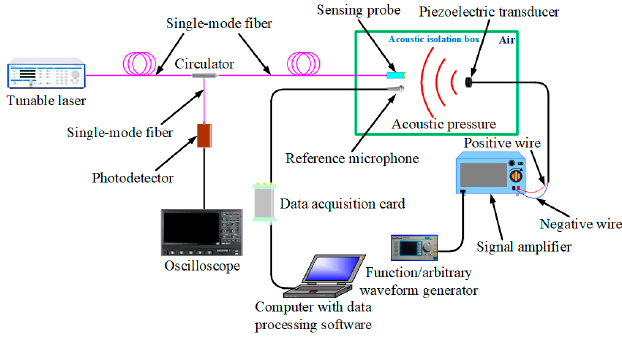
Figure 9. Platform for testing the proposed sensor performances.